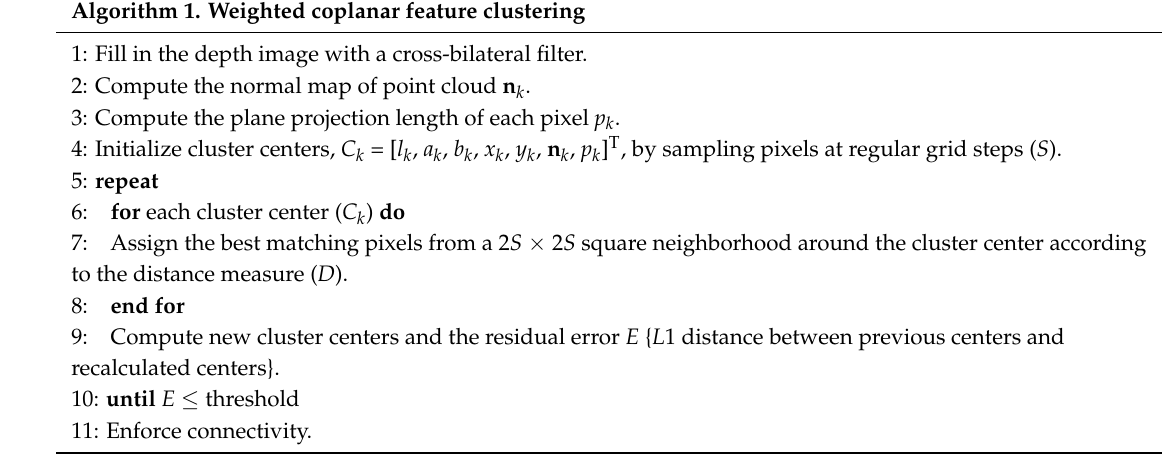
Algorithm 1. Weighted coplanar feature